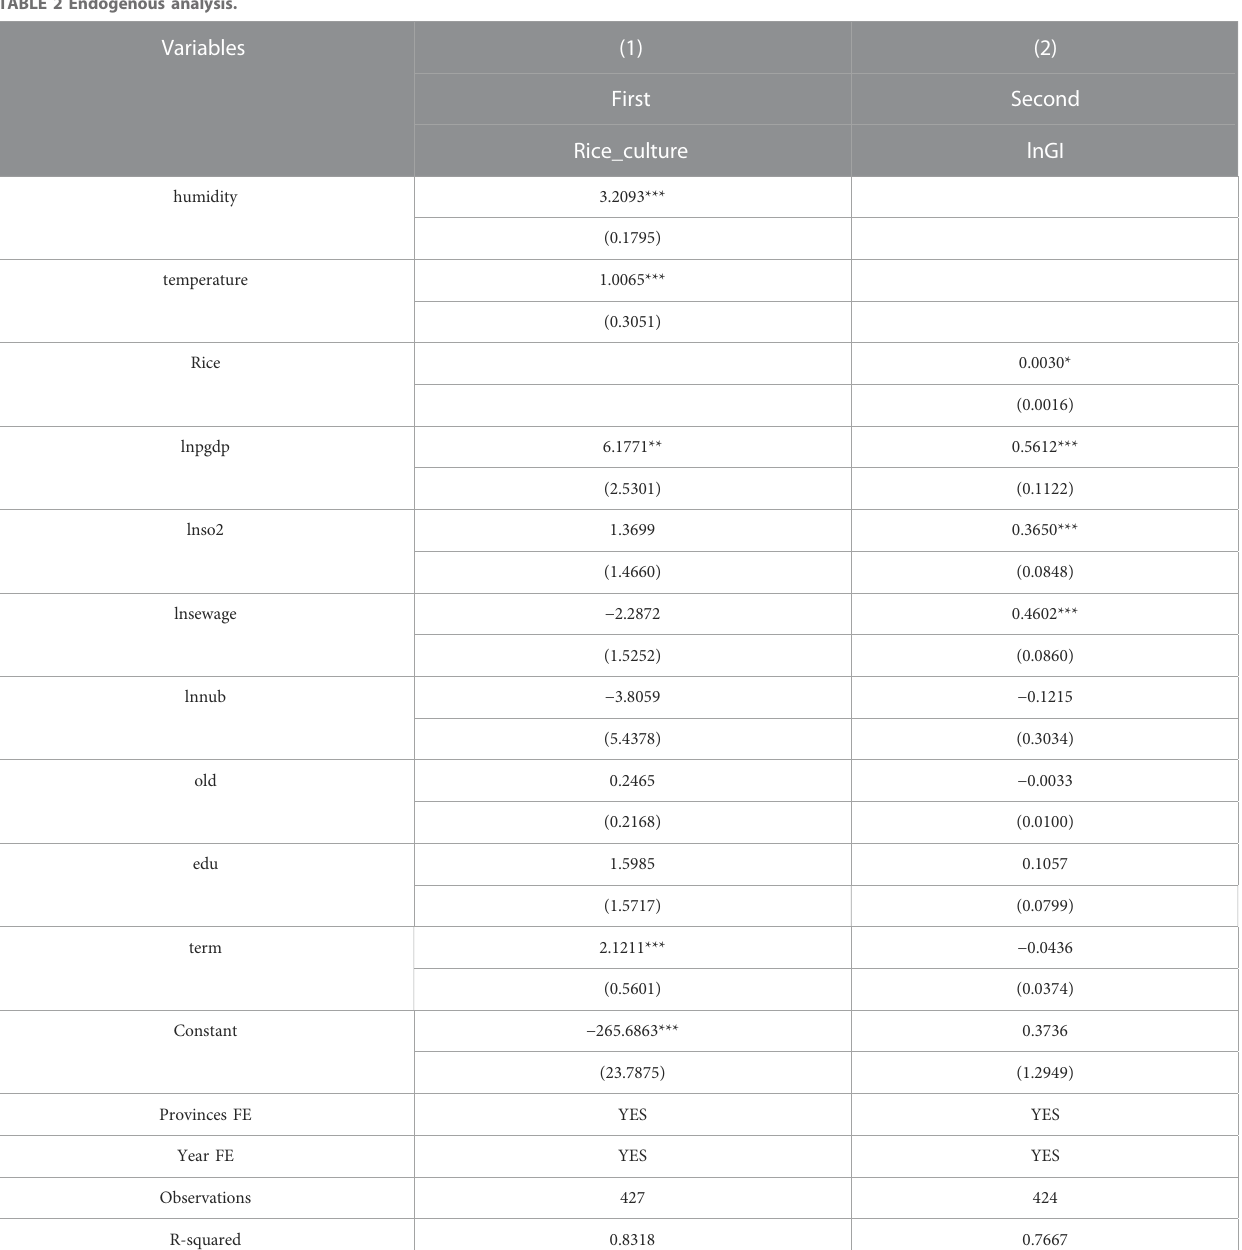
TABLE 2 Endogenous analysis.